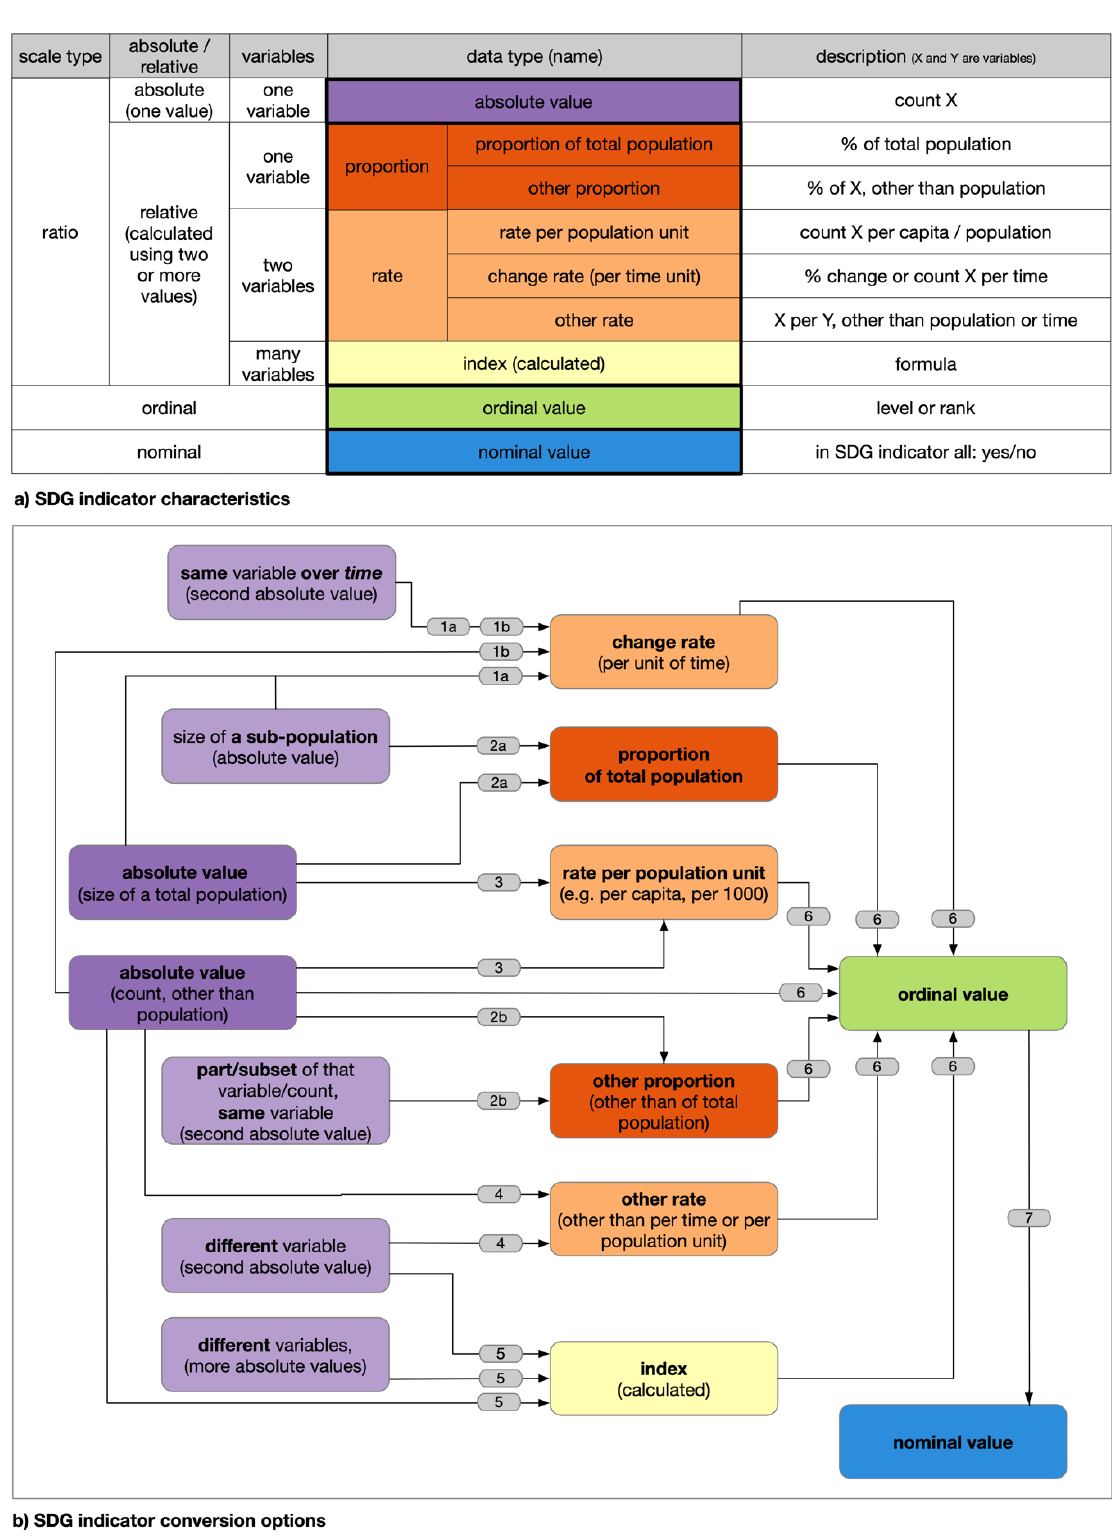
Figure 2. SDG indicators: ( a ) data characteristics; ( b ) data conversion options.